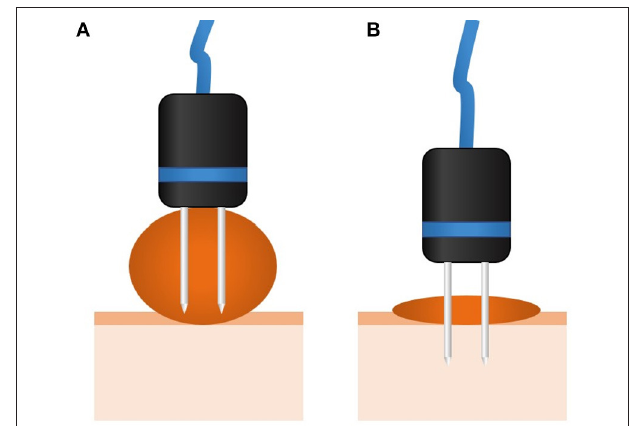
FIGURE 1 | Scheme showing the treatment of a tumor thicker than the needle’s length. In (A) , as can be seen, in a thick tumor the tumoral bed is not treated, leading to a relapse. In these cases, surgical debulking is recommended to achieve the situation in (B) . Otherwise, the same situation in (B) can be achieved by multiple ECT sessions, which should be already planned when the patient is evaluated for treatment.